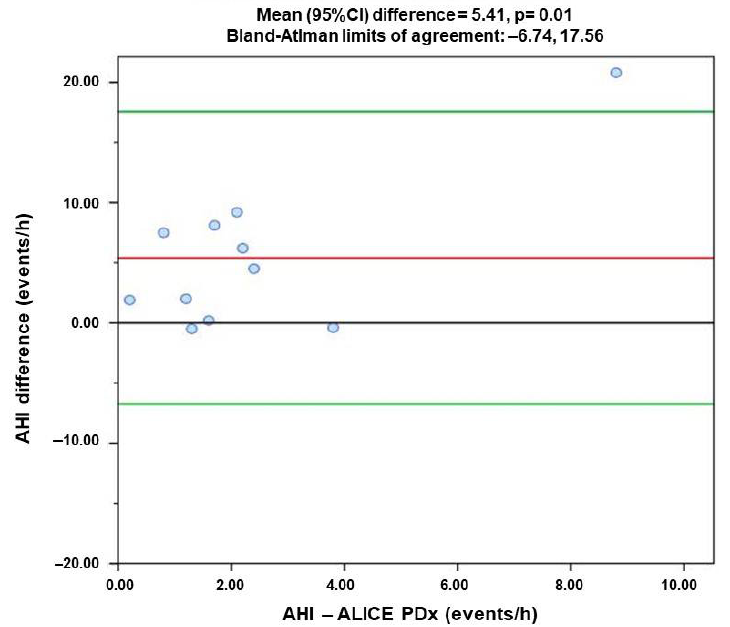
Figure 1. Bland-Altman plots. Distinction between the AHI-Alice PDx plotted against the two devices’ AHI difference ( n = 11). The red line presents the mean difference, while the green ones reveal the limits of agreement. AHI: apnea-hypopnea index.